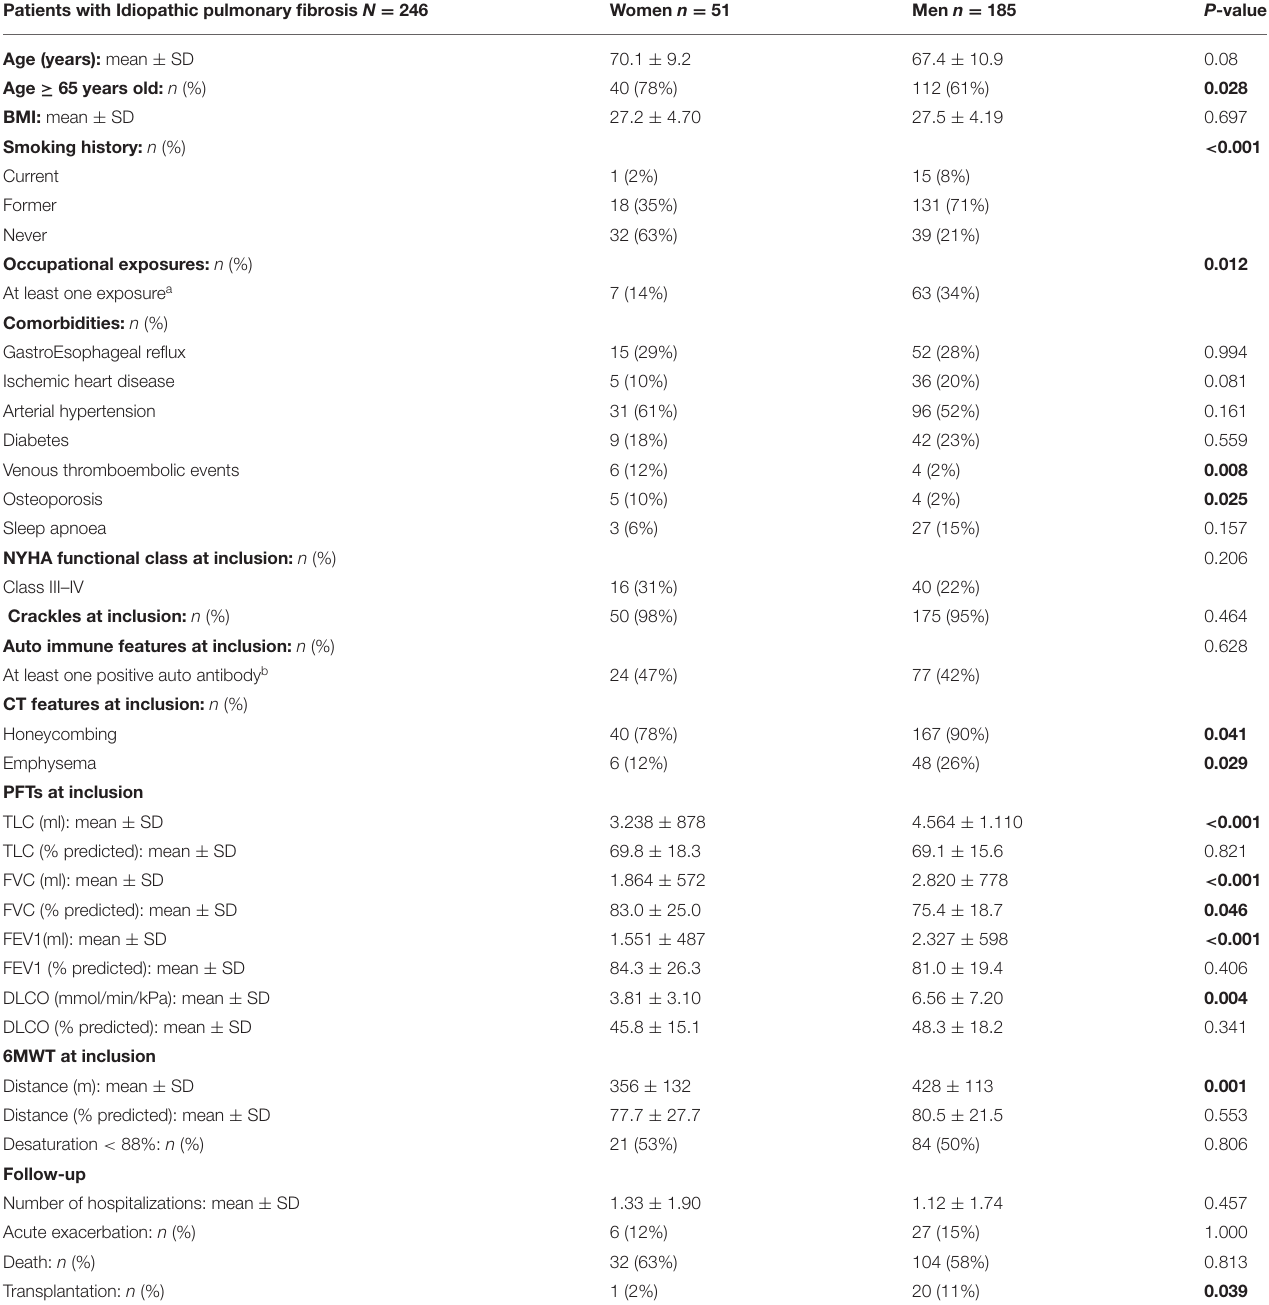
TABLE 1 | Characteristics of IPF patients included in COFI cohort according to gender. Patients with Idiopathic pulmonary fibrosis N =